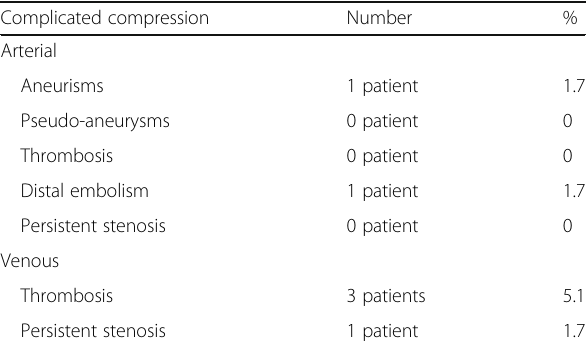
Table 3 Demonstrating the complications of vascular compression in thoracic outlet compression syndrome as well as the number and the percent of the affected